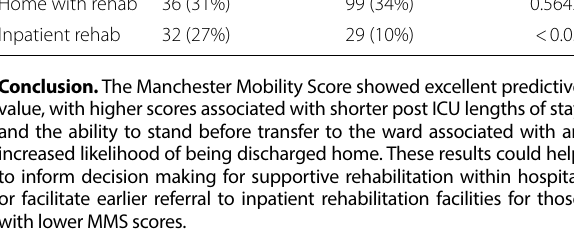
Fig. 1 Relationship between MMS at ICU disharge and post ICU length of stay